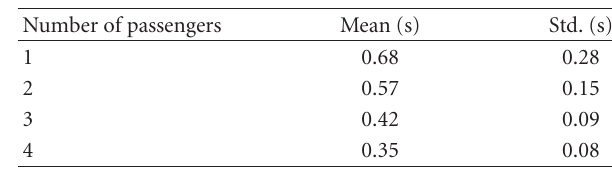
Table 3: Mean and standard deviation of γ for each number of